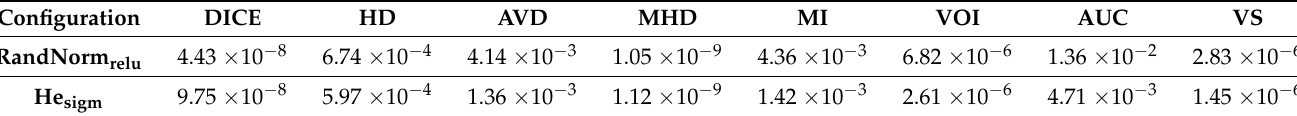
Table 7. p -Values for t -test with Glo tanh performed for Segmentation metrics on LiTS Database. Configuration DICE HD AVD MHD MI VOI